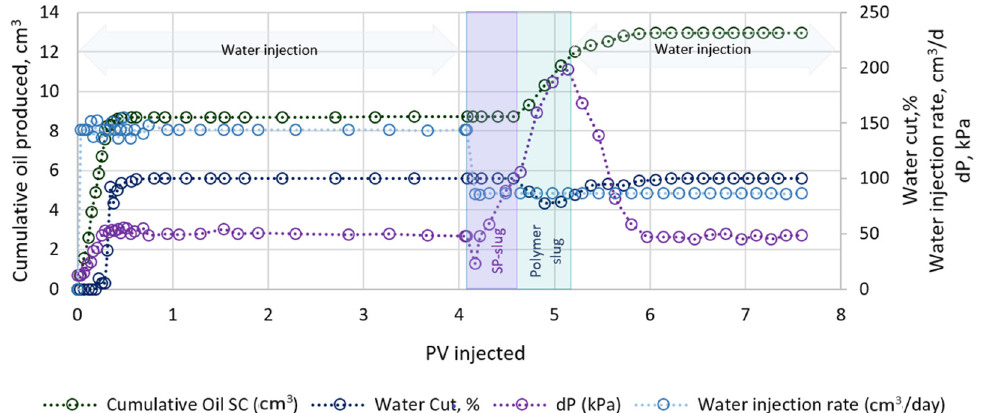
Figure 1. Dynamics of oil yield, water cut, water injection, and pressure drop during the experiment.